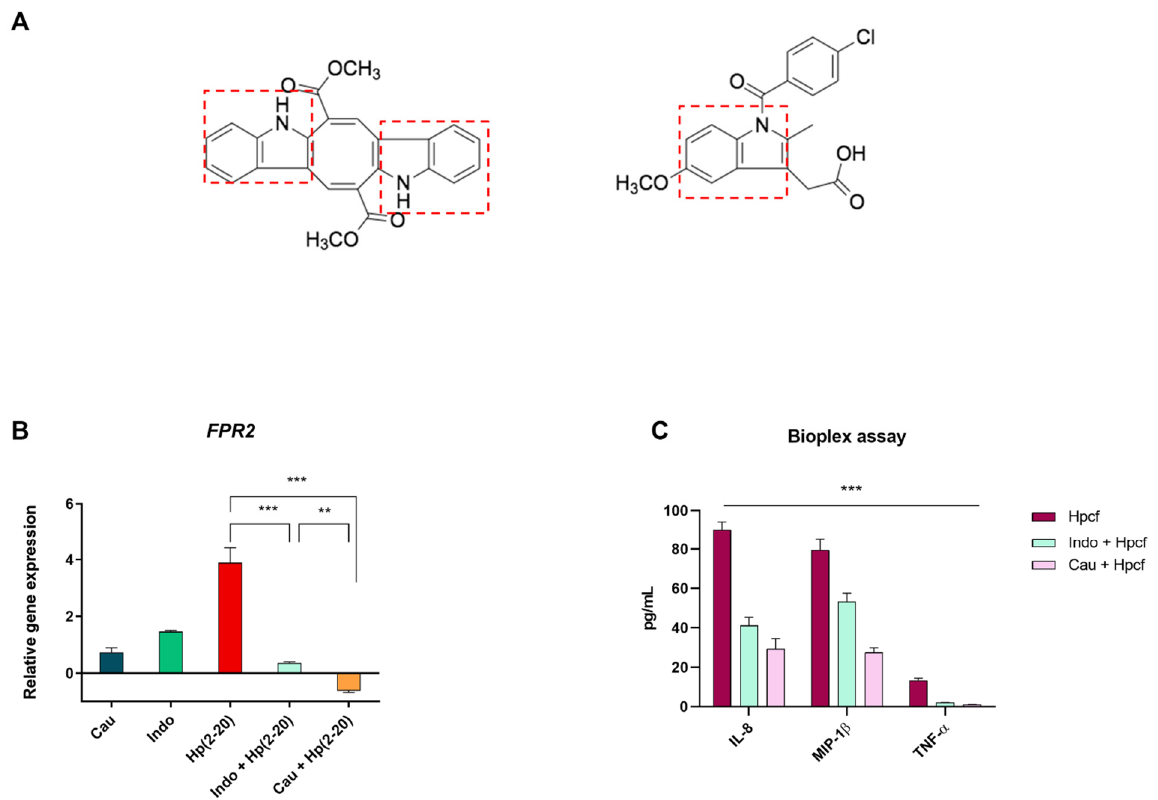
Figure 9. Cau possesses one additional indole nucleus to indomethacin and therefore major anti-inflammatory effects. ( A ) Molecular structure of Cau (on the left) is compared to indomethacin (on the right). Both Cau and indomethacin contain an indole scaffold, indicated with a red square. ( B ) Relative gene expression of FPR2 by quantitative real time PCR (qPCR) in cells treated with: (1) Cau 15 µM for 2.5 h; (2) WRW4 10 µM for 2.25 h; (3) Hp(2–20) 25 µM for 2 h; (4) Cau 15 µM for